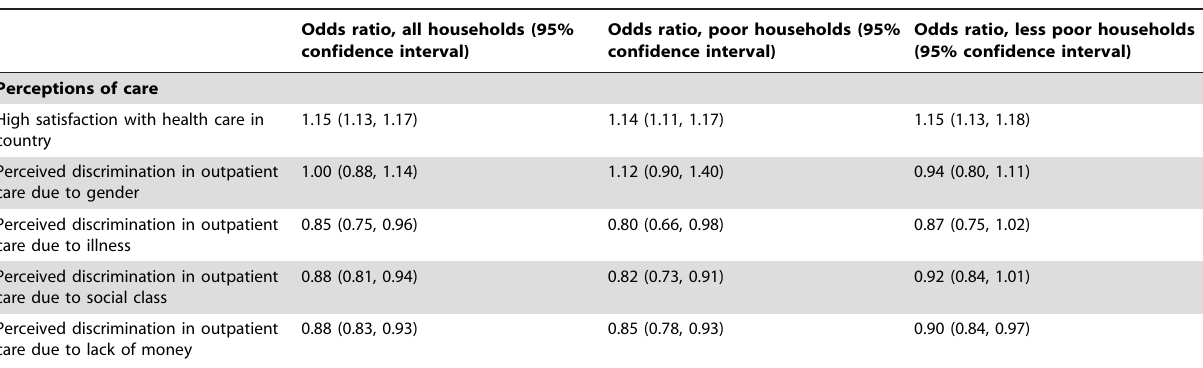
Table 5. Relationship of gender to perceptions of care among adult respondents*.